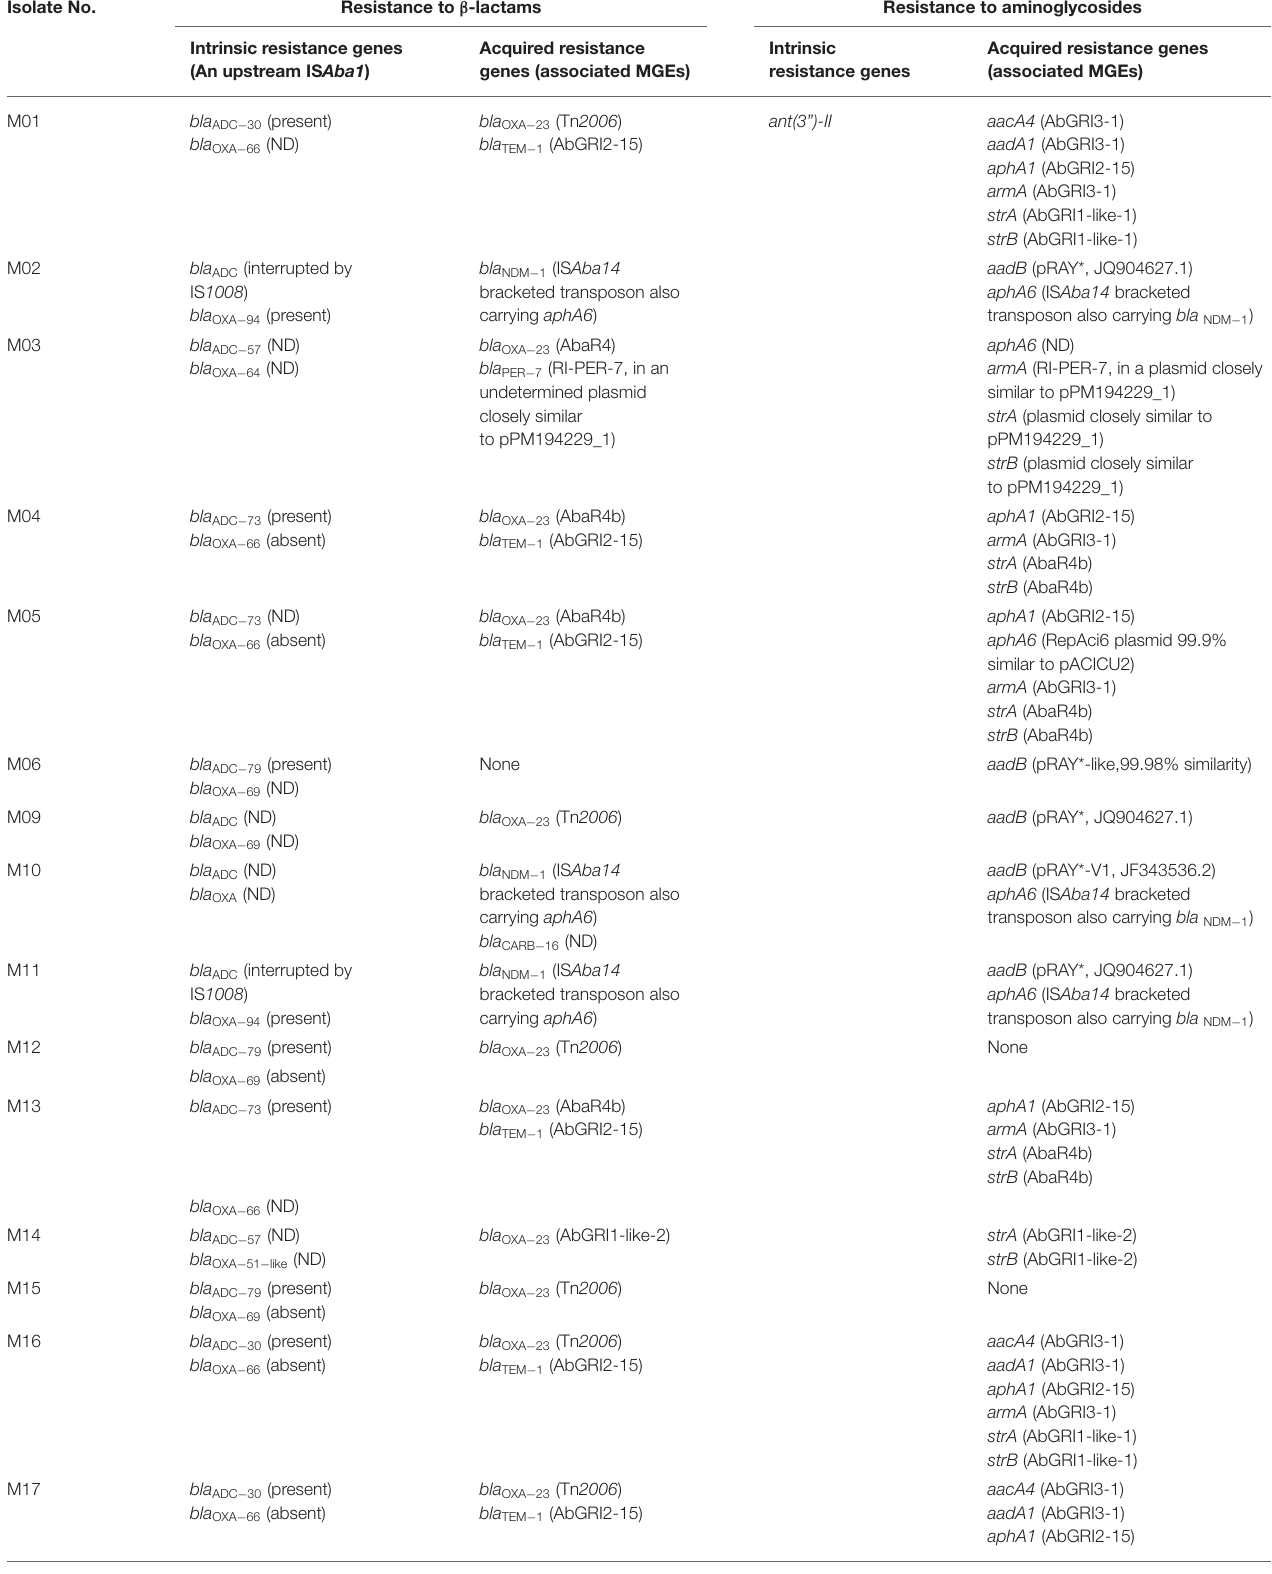
TABLE 2 | β -lactam and aminoglycoside resistance determinants and their context. Isolate